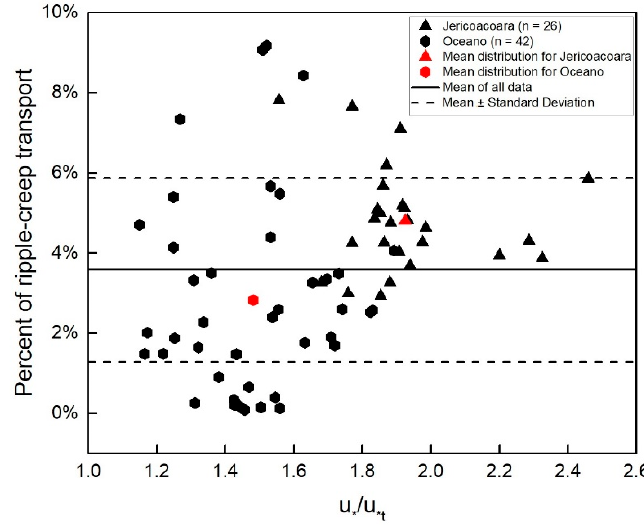
Figure 5. The percent of total transport carried by ripples compared to dimensionless shear velocity. The proportion was approximately independent of u * / u *t for the independent data sets but may indicate a weak dependence for the combined data based on the means of the two populations.